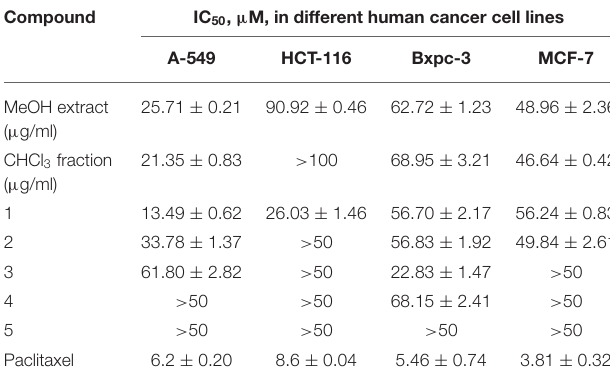
TABLE 2 | Cytotoxicity of extract, fraction, and isolated compounds (1–5) a .